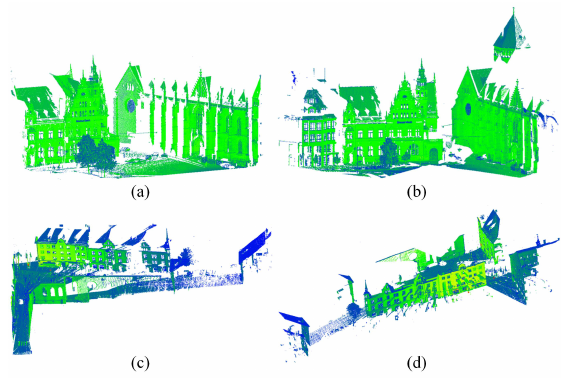
Figure 6. (a) Source and (b) target scans of Bremen datasets. (c) Source and (d) target scans of ETH